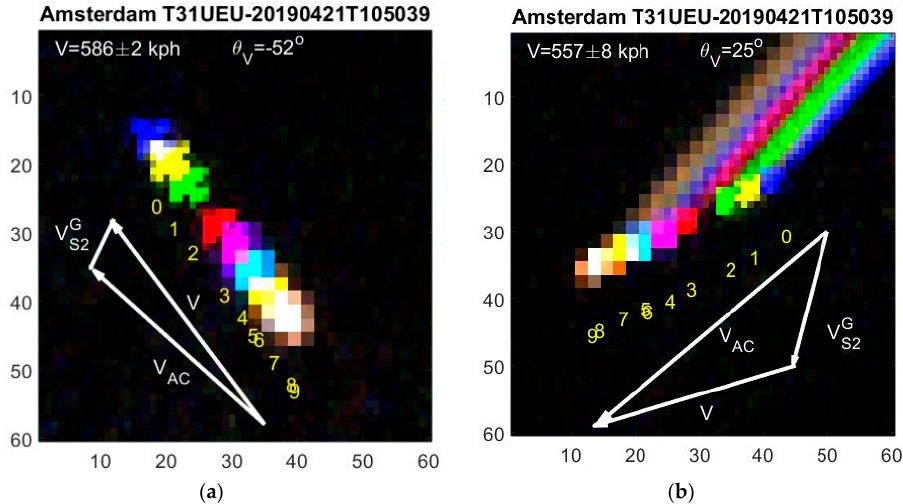
Figure 4. Planebows. Scale in pixels. ( a ) A slow and low flying aircraft near Amsterdam airport after takeoff recorded in 10 multispectral images with offsets. Red, green and blue are true colors whereas the seven remaining colors are overlayed with false colors, e.g., m = 1 is yellow. Numbers 0, ..., 9 indicate the central aircraft position in each band (but moved 10 pixels down). The triangle shows the → → → → G = V ), aircraft ( V AC ) and satellite ( V V S 2 H AC / H S 2 ) velocity vectors. ( b ) Planebow of a apparent ( S 2 fast flying aircraft at high altitude near Amsterdam with strong contrails from each wing